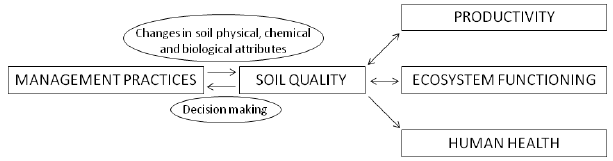
Figure 1. Interconnection between management practices, soil quality, productivity, environmental functions and soil health. Only indirect effects of management practices on other components through soil quality are taken into